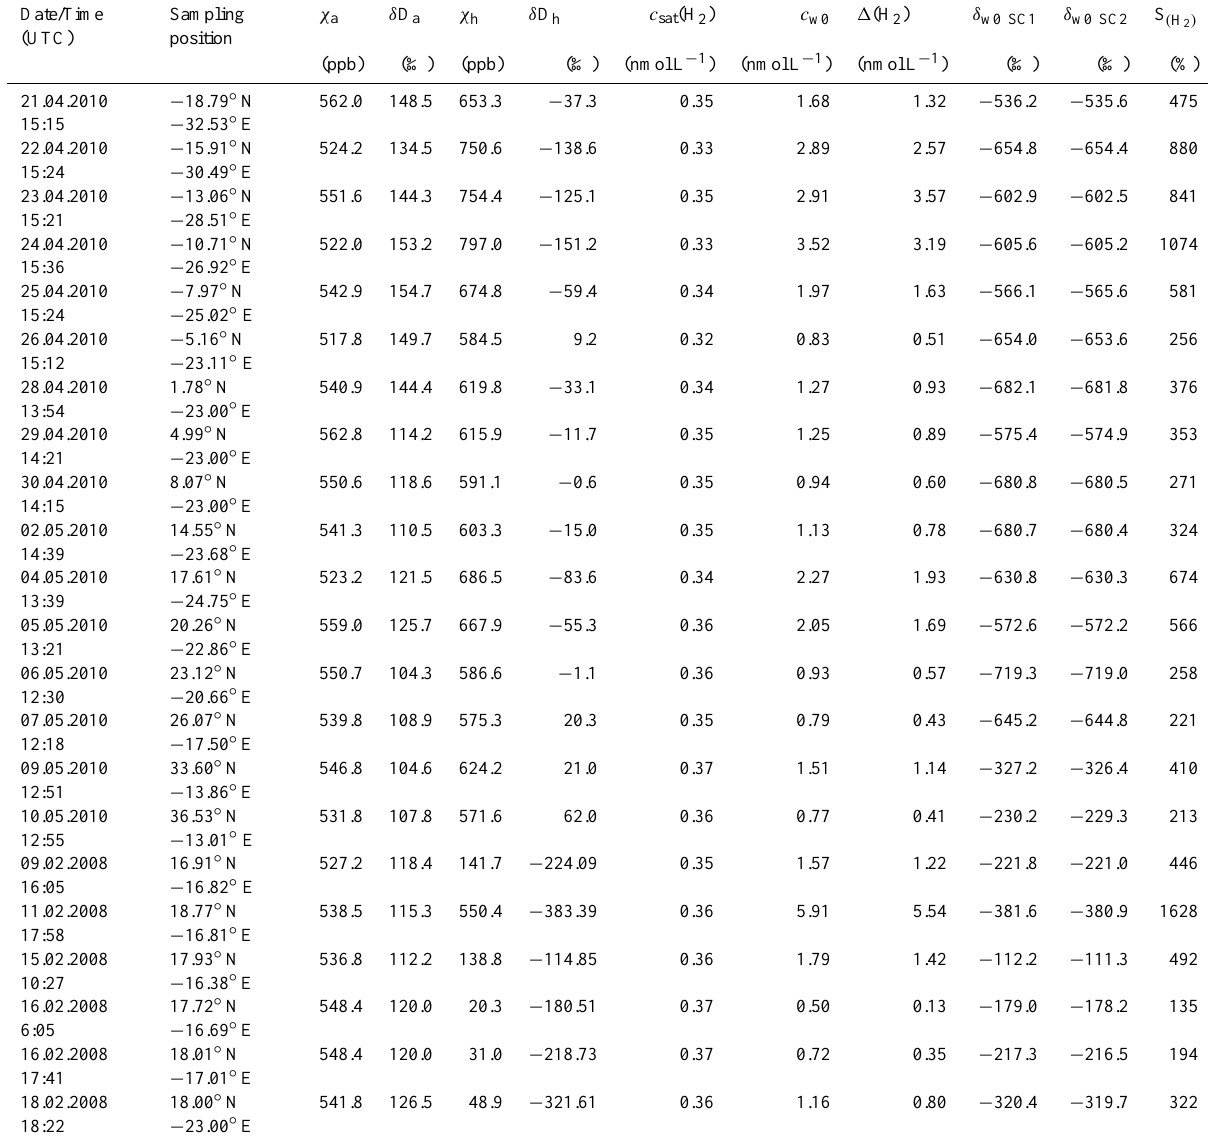
Table 4. Overview of headspace sample results from the ANT-XXVI/4 cruise (2010) and the L’Atalante ATA-3 (2008),: χ h is the measured mole fraction of the headspace in parts per billion (ppb = nmolemole − 1 ), χ a is the corresponding atmospheric mole fraction in ppb, δ D h and δ D a is the measured isotopic composition in permil (‰). The H 2 equilibrium concentration c sat (H 2 ) was determined by using the equations from Wiesenburg and Guinasso (1979), the initial dissolved H 2 concentration c w0 is calculated as given in Supplement 1, and the excess (cid:49) H 2 is the difference between them. δ w0 SC1 and δ w0 SC2 show the two scenarios to derive the initial isotope delta of dissolved H 2 . S ( H is the saturation of H 2 in the surface water. The calculated extraction efficiency was 92.12 ( ± 0.013)%. The calculations are given in the Supplement in more